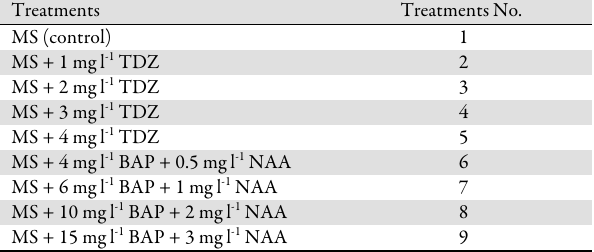
Table 1. Treatments in embryogenesis from leaf explants